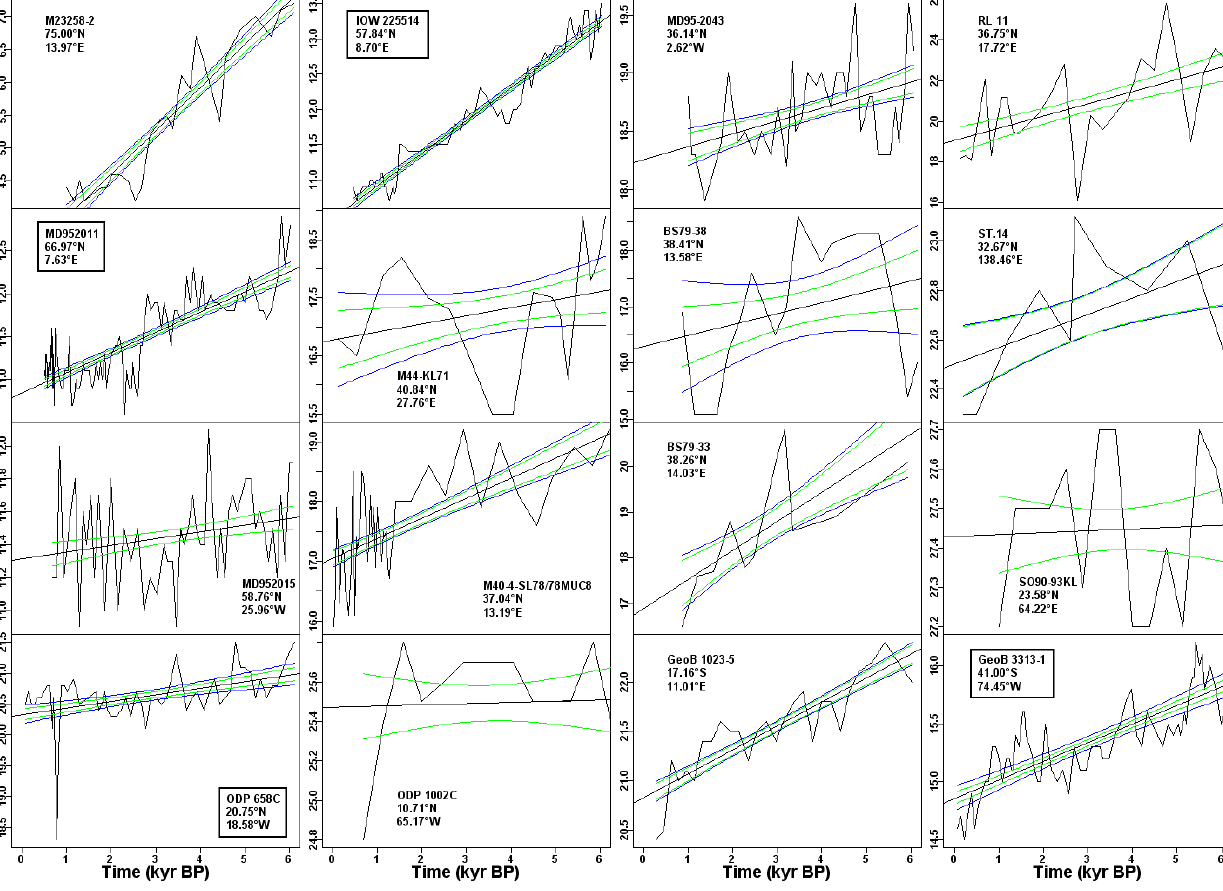
resolve the equatorial wave guide, and this resolution